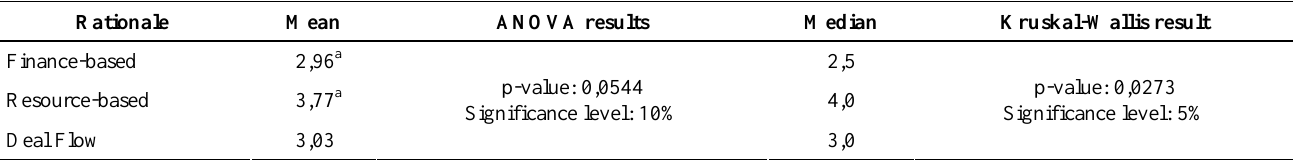
Table 2: Joint tests for differences in the rationales for syndication